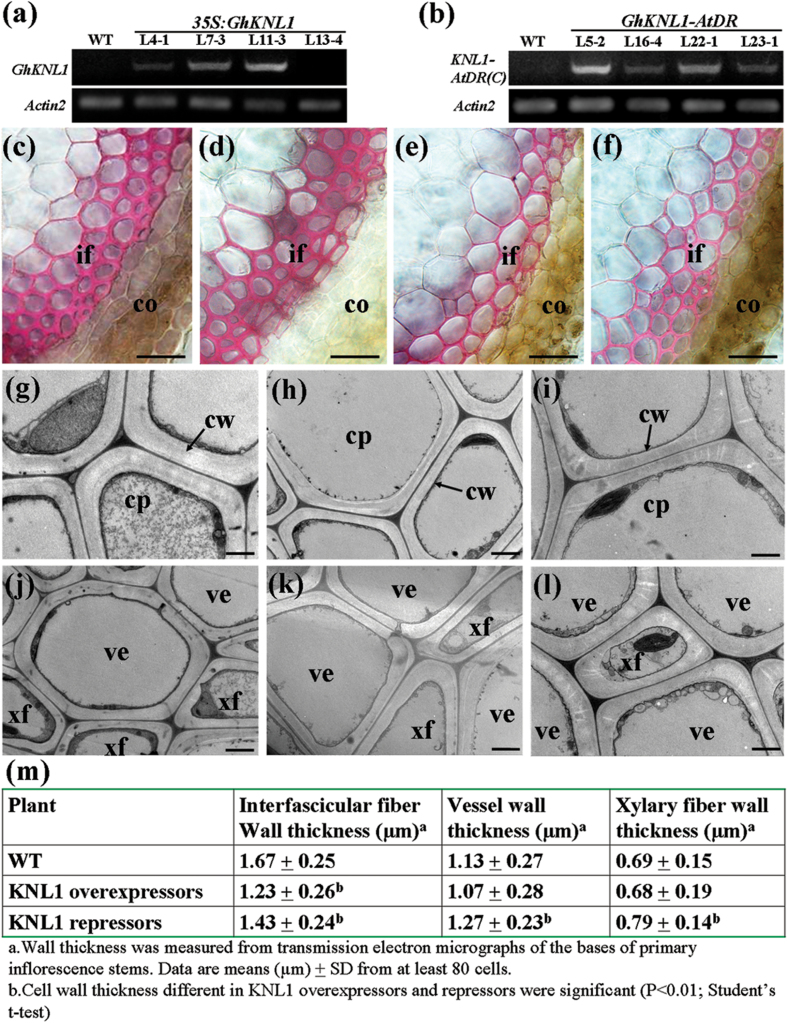
Assay of SCW thickening in fibres and vessels of GhKNL1 transgenic Arabidopsis plants. The inflorescence stems of 6-week-old plants were used for examining SCWs of fibres and vessels. (A, B) Real-time quantitative RT-PCR analysis showing the presence of the GhKNL1 overexpressor (35S:GhKNL1) and repressor (GhKNL1-AtDR) transcripts in the stems of four independent lines, respectively. Expression level of Actin2 was used as a control. (C–F) Phloroglucinol-HCl staining of stem cross-sections of wild-type, 35S:GhKNL1, and GhKNL1-AtDR transgenic seedlings: (C) wild type; (D) 35S:GhKNL1 transgenic line 13–4, negative control; (E) 35S:GhKNL1 transgenic line 11–3; (f) GhKNL1-AtDR transgenic line 5-2. (G–L) Transmission electron micrographs of stem transections of wild-type, 35S:GhKNL1, and GhKNL1-AtDR transgenic plants, showing the thickened cell wall of interfascicular fibres (G–I) and vessels (J–L): (G, J) wild type; (H, K) 35S:GhKNL1 line 11–3; (I, L) GhKNL1-AtDR line 5-2. (M) SCW thickness of interfascicular fibres and vessels in stems of wild-type, 35S:GhKNL1 and GhKNL1-AtDR transgenic plants. Bar = 50 µm in (C–F) and 2 µm in (G–L). co, Cortex; if, interfascicular fibre; cp, cytoplasm; cw, cell wall; ve, vessel; xf, xylem fibre.